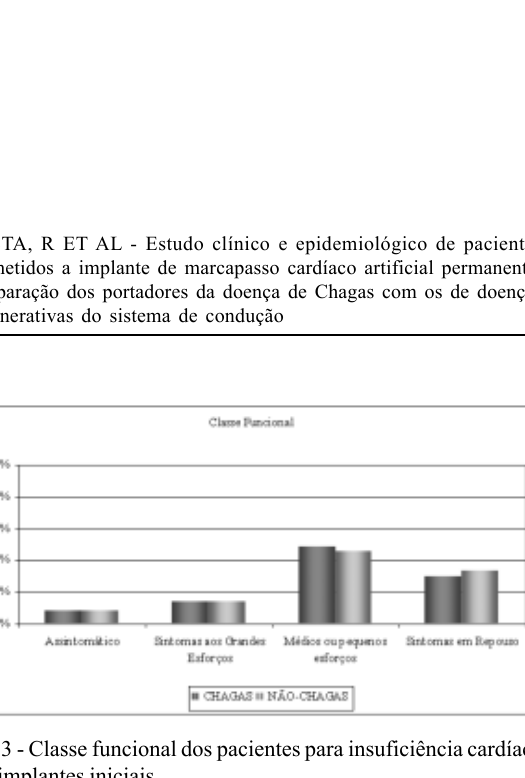
Achados do ECG Ritmo sinusal normal BAV de 1º grau BAV de 2º grau